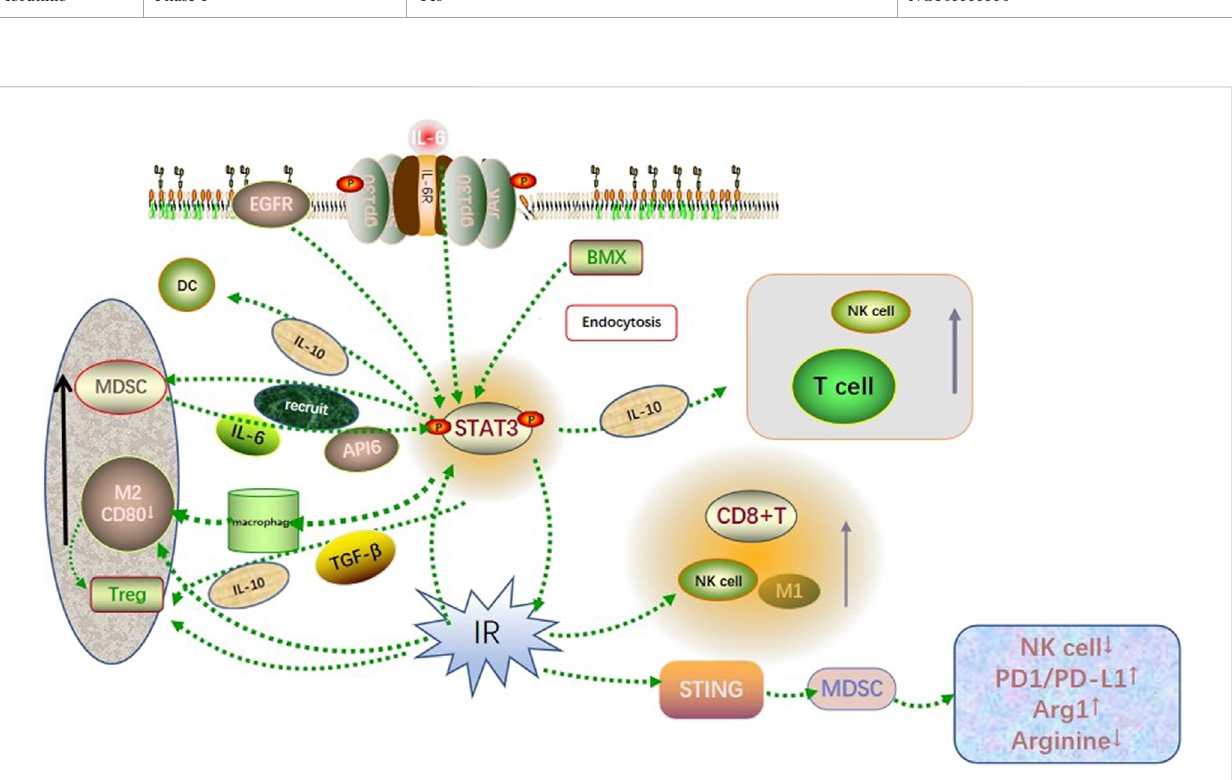
FIGURE 1 Co-in fl uence of STAT3 and radiation on the GBM microenvironment. Activated STAT3 recruited immunosuppressive cells such as MDSC, M2-like TAM, and Treg to in fi ltrate the GBM microenvironment through cytokine signaling such as IL-6, IL-10, and TGF- β . Besides, it involved in recruiting immune cells such as T cells, DC cells, and NK cells to accumulate toward the tumor site. The radiation-induced DNA damage triggered the recruitment and activation of NK cells, M1-like TAM, CD8 + T cells, and other immune killer cells, while activation of the STING pathway leading to excessive activation of the PD1/PDL1 pathway and reduced arginine levels in the tumor microenvironment. Both showed synergistic and antagonistic effects on immunity, which fi nally resulted in the immunosuppression state in the GBM